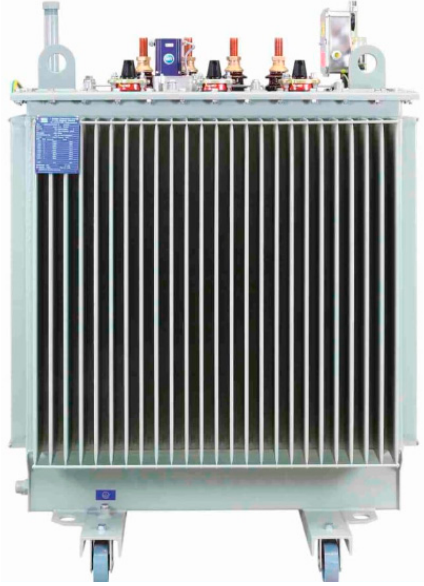
Figure 1. A VRDT with an OLTC